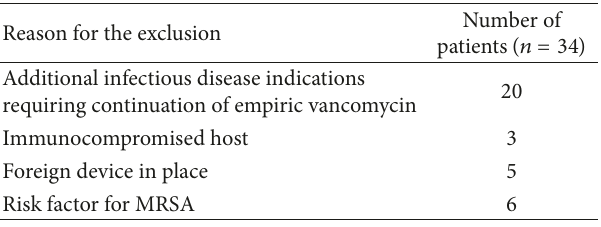
Table 2: Patients who did not meet inclusion criteria for rapid diagnostic testing a